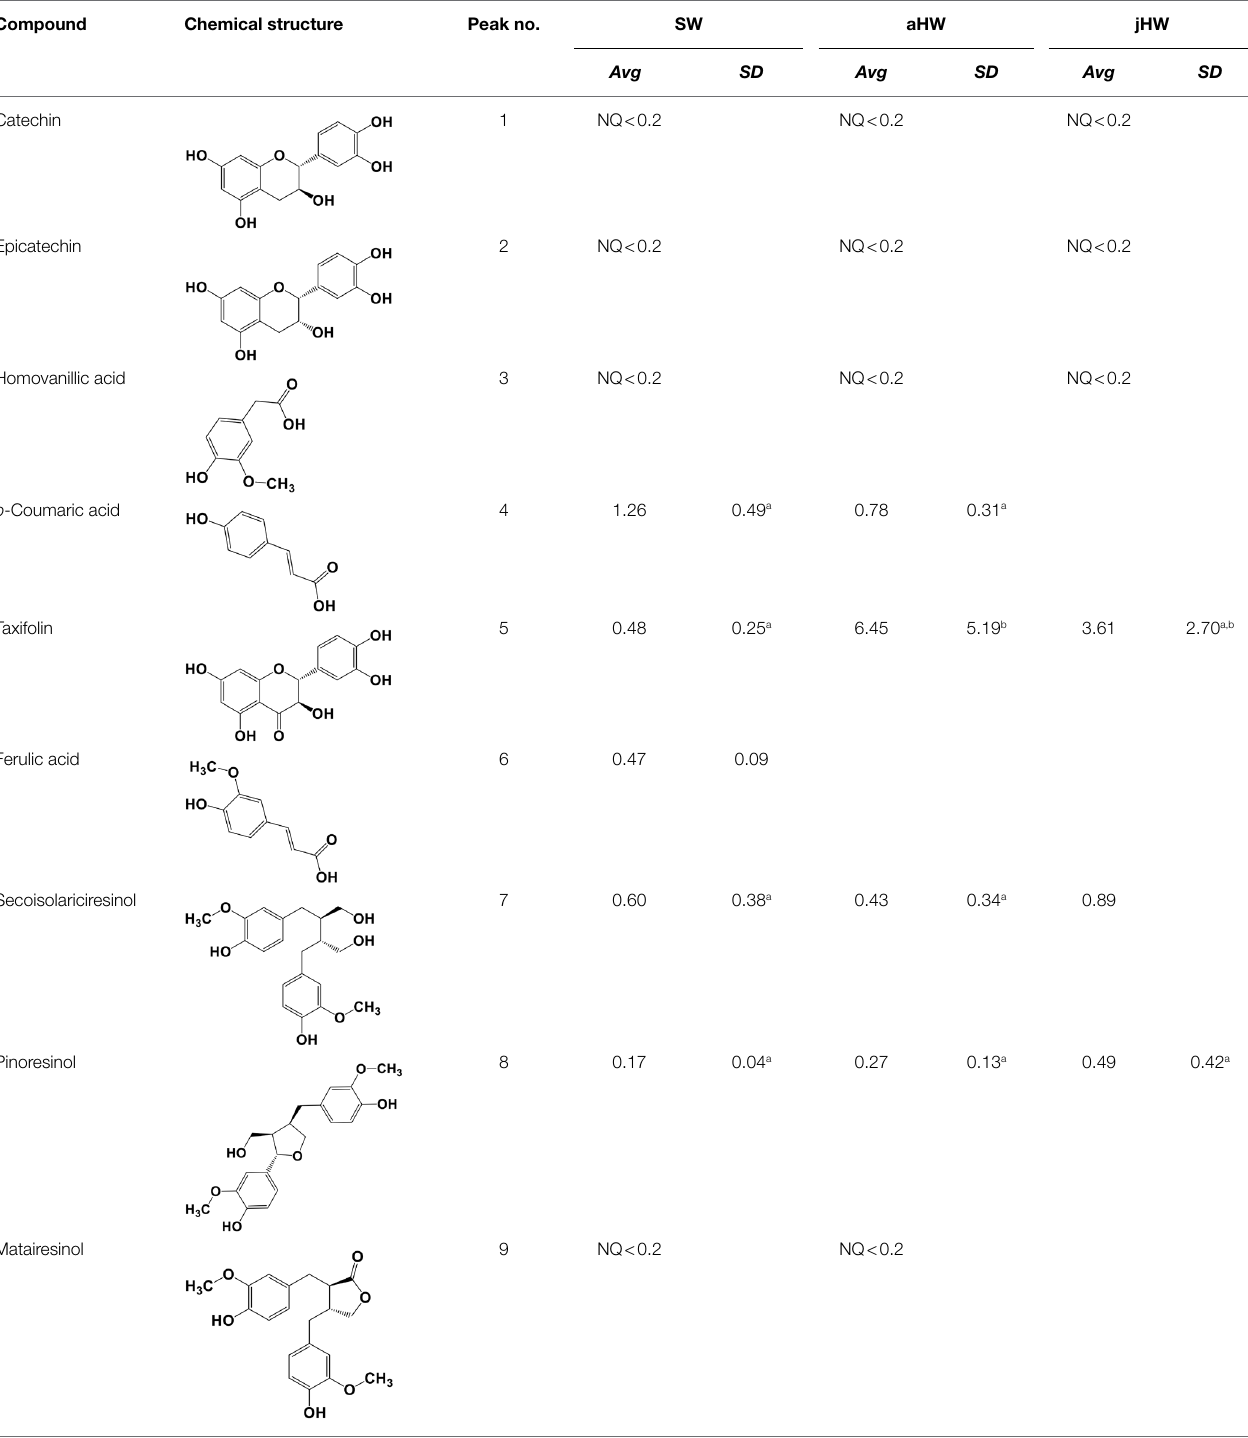
TABLE 2 | Chemical composition of phenolic extractives in sapwood and heartwood of Douglas fir ( Pseudotsuga menziesii ). Compound Chemical structure Peak